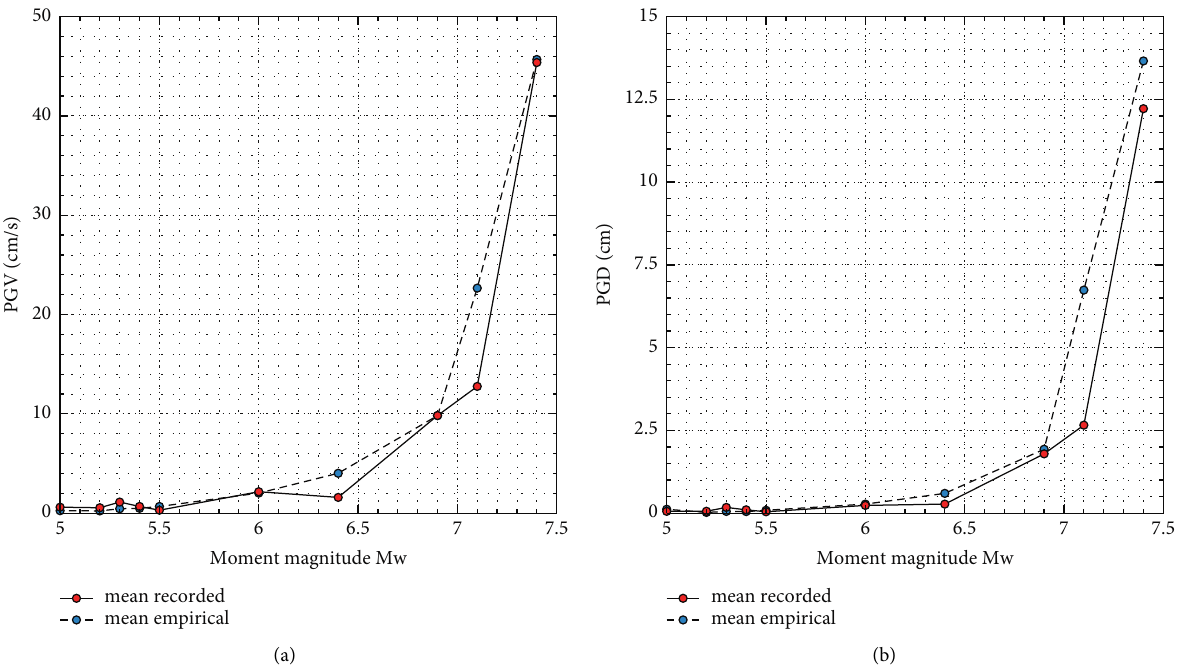
Figure 7: Variation with the earthquake magnitude of the mean observed and predicted (a) peak ground velocities and (b) peak ground